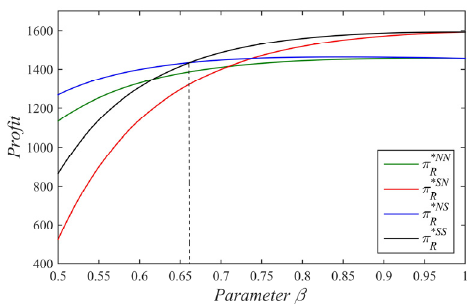
β β on the profits of retailer. β on the profits of retailer. Figure 12. The impact of parameter β on the profits of retailer. on the profits of retailer.